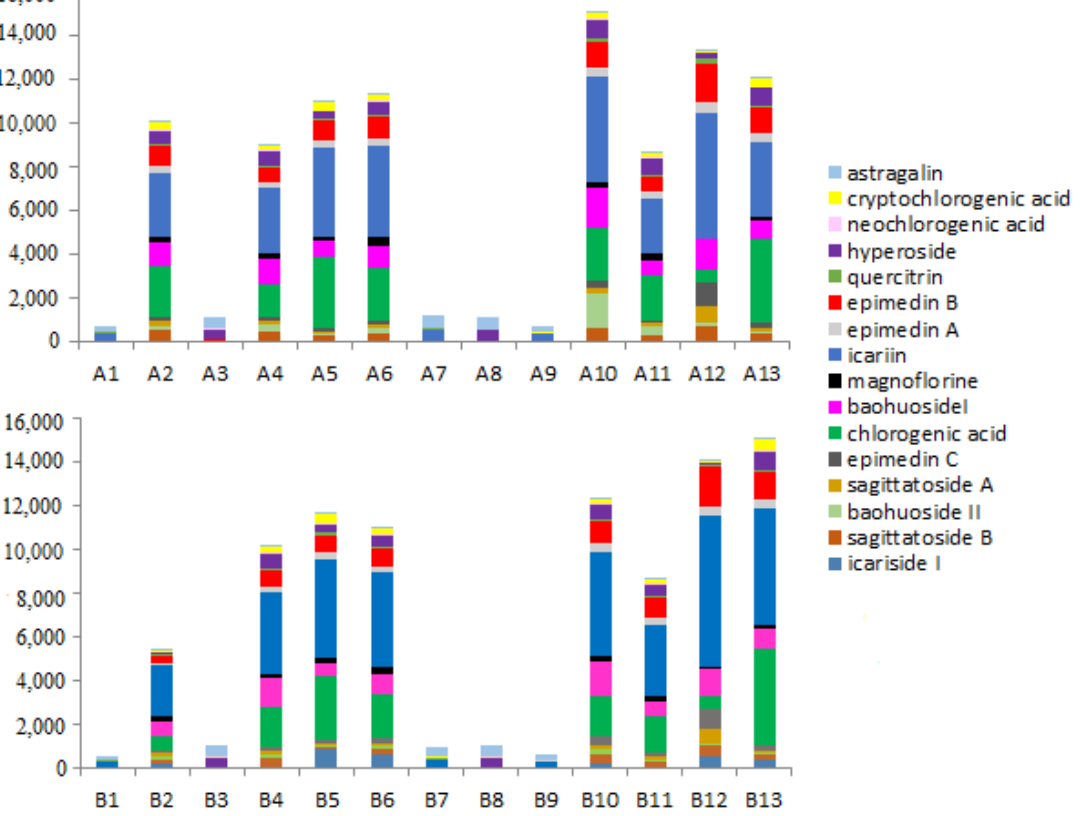
Figure 3. Contents of 16 components in different batches of raw and processed Epimedium ( µ g/g): (A) raw; (B) processed. The sample numbers were same as in Table 1.